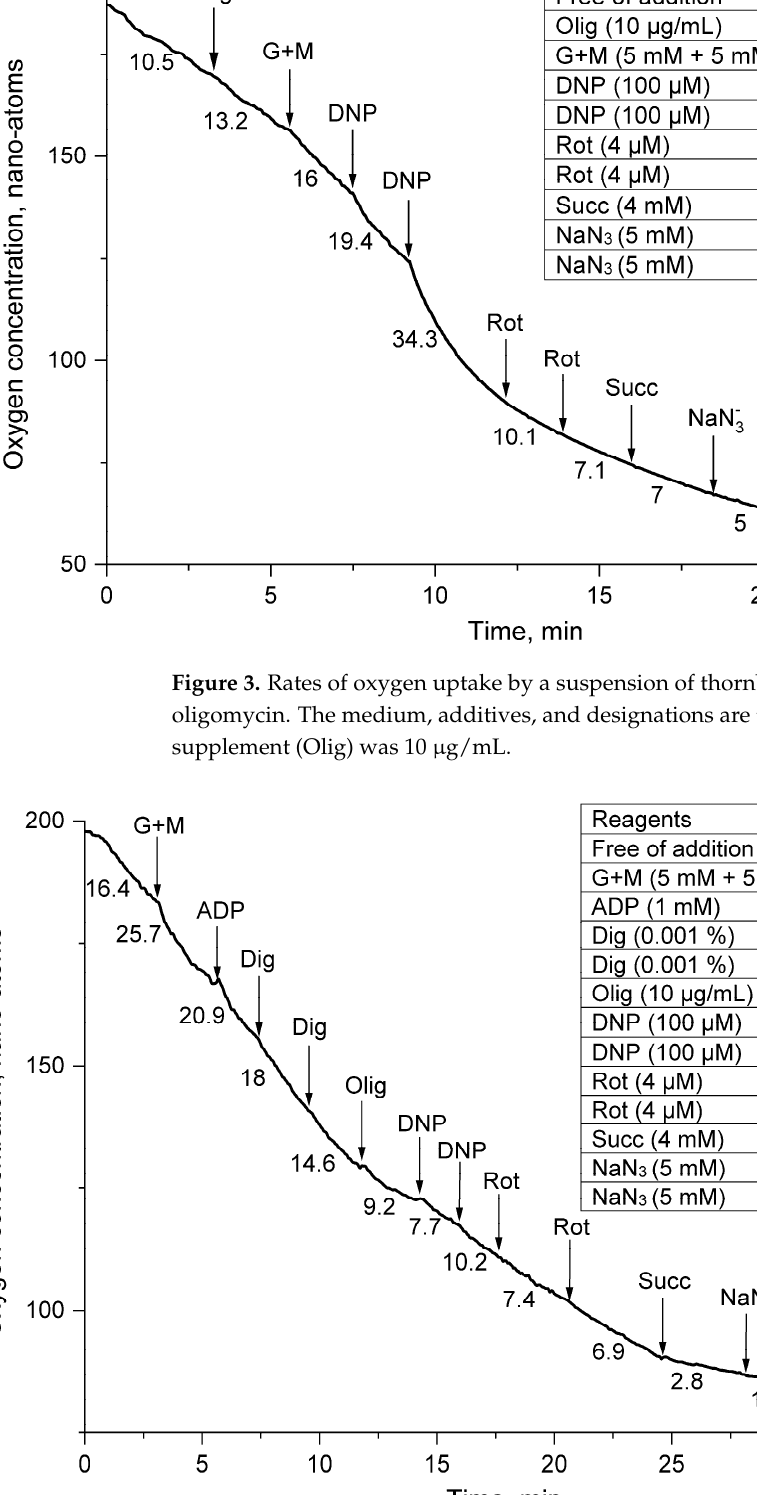
Figure 4. Rates of oxygen uptake by a suspension of thornback ray erythrocytes permeabilized with digitonin. The medium, additives, and designations are the same as in Figure 3. The concentration of ADP introduced into the medium was 1 mM; digitonin (Dig) was 0.01.